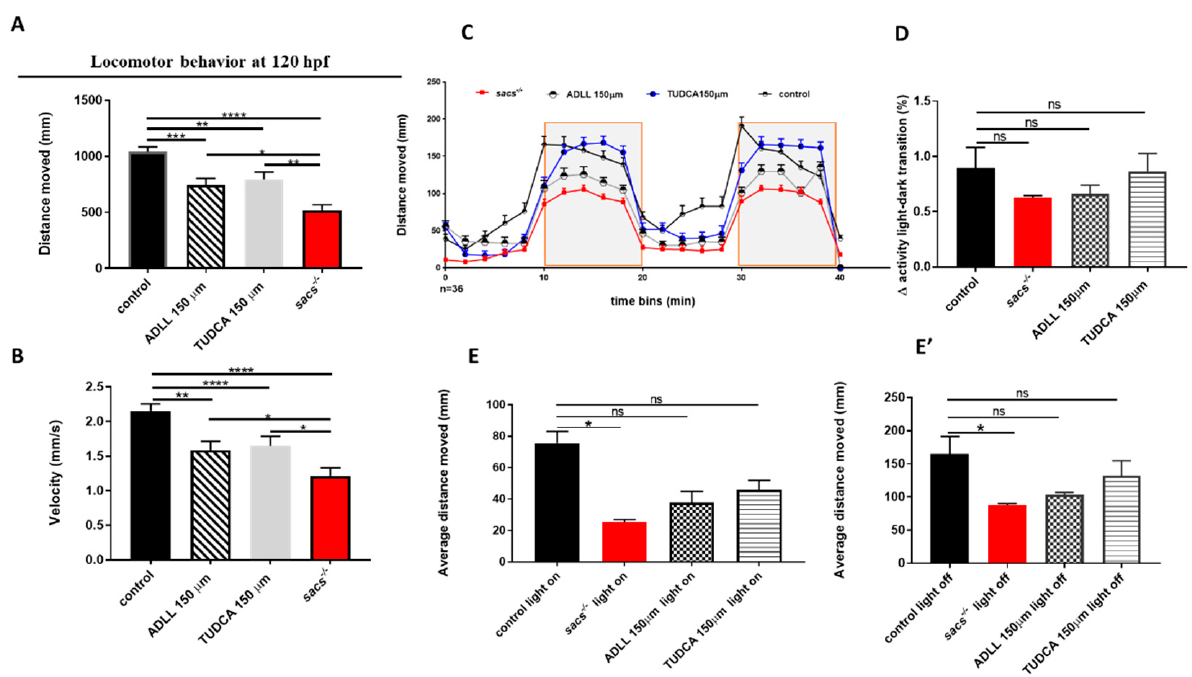
Figure 4. Treatment of homozygous sacs − / − mutants with TUDCA and ADLL is able to rescue the locomotor impairment seen in sacs − / − larvae. ( A , B ) Automated analysis of spontaneous motor activity of sacs − / − after drug treatments (untreated sacs − / − n = 100; sacs − / − mutants treated with ADLL/Tanganil™ n = 150; sacs − / − mutants treated with TUDCA n = 150; controls n = 167) in 4 independent experiments. * p ≤ 0.05, ** p ≤ 0.01, *** p ≤ 0.001, **** p ≤ 0.0001were calculated by the Mann-Whitney test. ( C ) Swimming pattern of sacs − / − after drug treatments (untreated sacs − / − n = 34; sacs − / − mutants treated with ADLL/Tanganil™ n = 34; sacs − / − mutants treated with TUDCA n = 34; controls n = 34). Each point in the graph represents the mean ± standard error of the mean of the distance moved by zebrafish larvae in 2-min time bins. The shaded parts represent the dark and the unshaded parts the light periods. The total number of embryos used for each group tested was 36. ( D ) Between-group differences in the average total activity were evaluated by comparing 1 min after and 1 min before light-to-dark and dark-to-light transitions. Values are represented as means ± standard error of the means. ( E , E’ ) The average of the total activity of each group was measured during light on ( E ) and light off ( E’ ) conditions. * p ≤ 0.05, calculated by Dunnett’s multiple comparisons test. Abbreviations: n , number of evaluated embryos in total; ns, not significant.